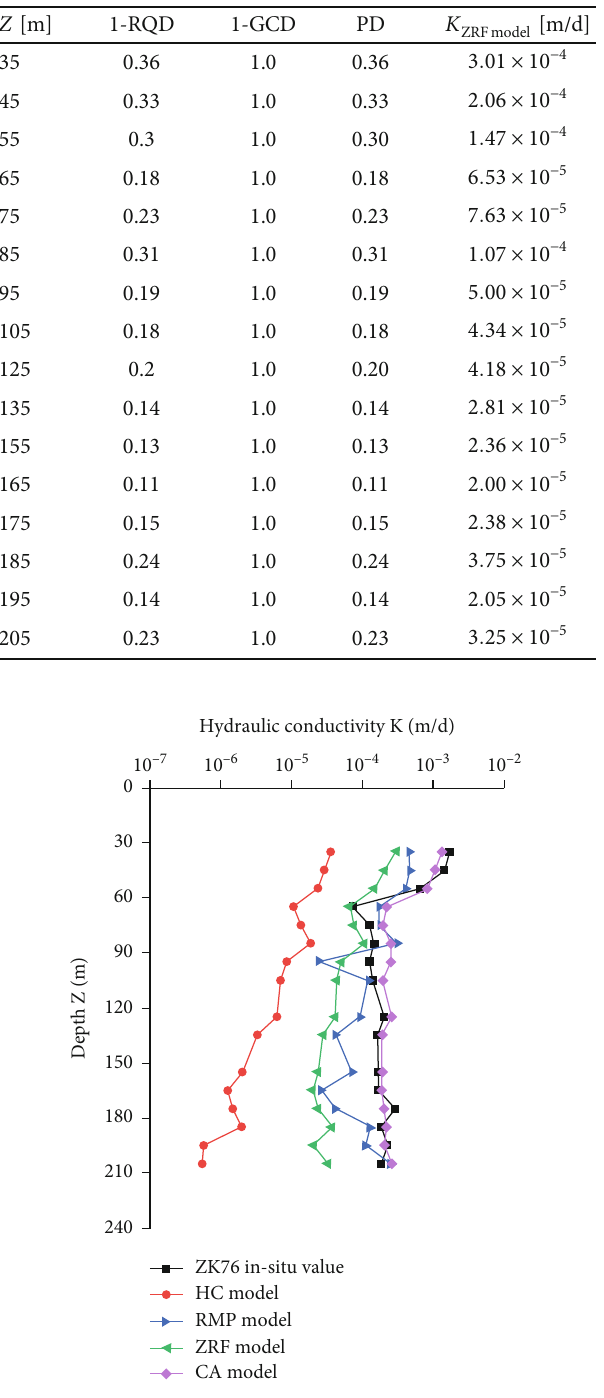
Figure 11: Comparison between the estimated values of hydraulic